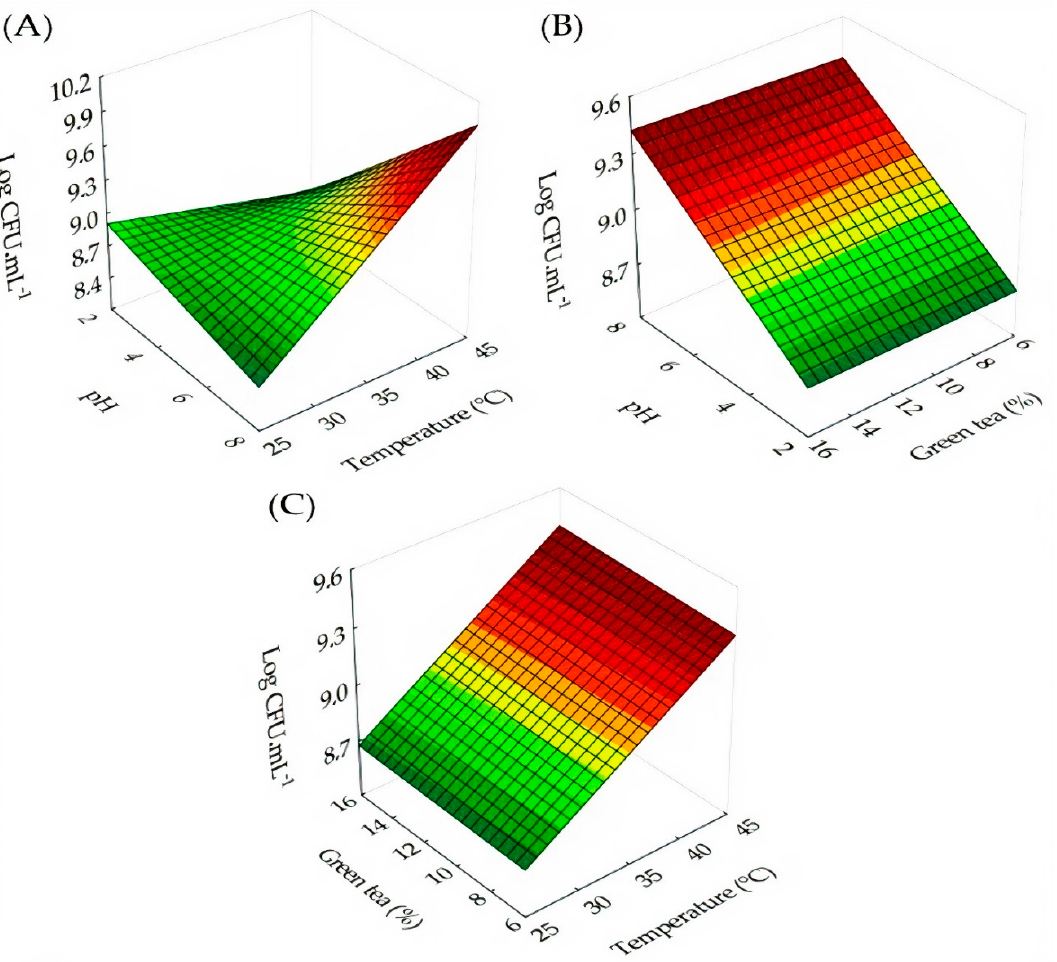
Figure 4. Effect of incubation pH and temperature ( A ), green tea pH and concentration ( B ), and green tea concentration and incubation temperature ( C ) on the maximum concentration of L. gasseri cells in passion fruit juice.